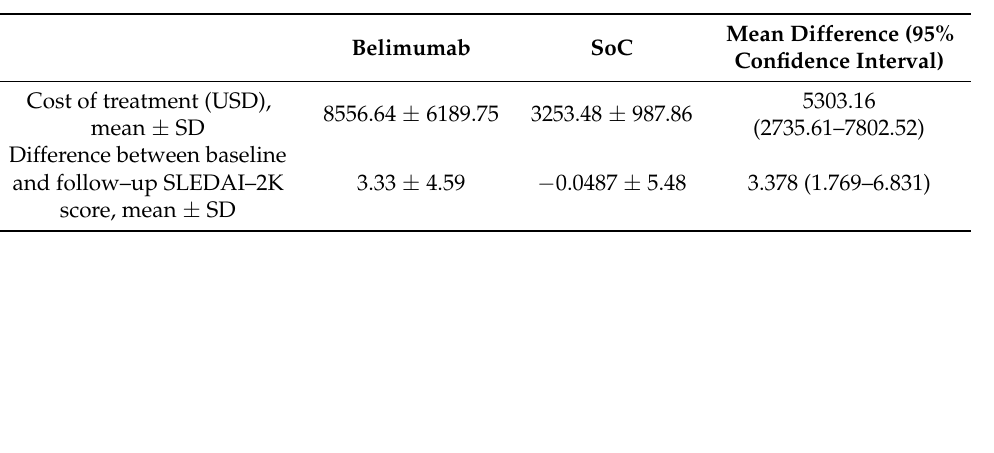
Figure 1. Mean treatment costs of belimumab-based treatment regimens and the standard of care (SoC). Table 2. The mean Systemic Lupus Erythematosus Disease Activity Index 2000 (SLEDAI–2K) score difference between the baseline and follow-up period and treatment costs for a belimumab-based treatment regimen versus the standard of care